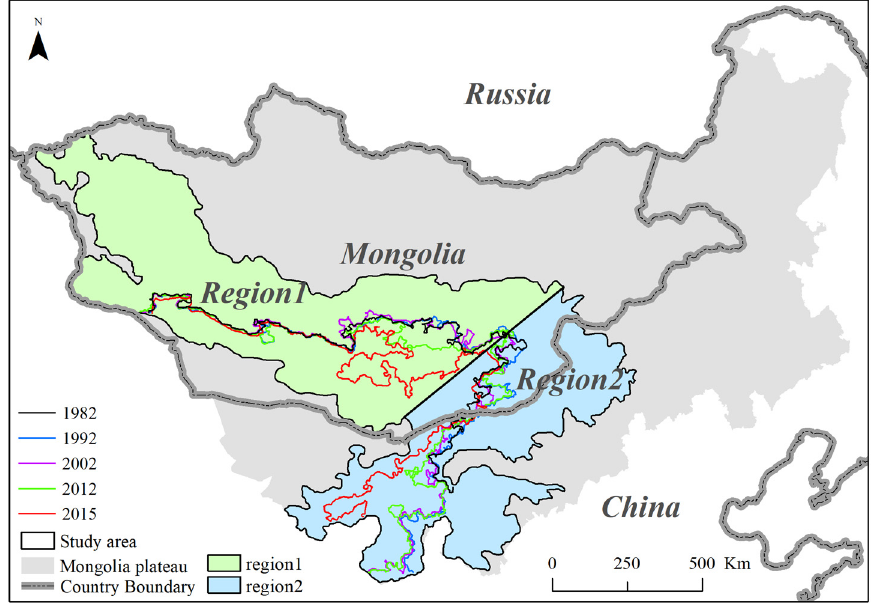
Figure 5. Spatial changes of vegetation greenness line during 1982–2015 in ASTZMP. To quantify the latitudinal and longitudinal changes in the vegetation greenness line, we analyzed changes in the latitude (Region1) and longitude (Region2) at the center point of the vegetation greenness line (Figure 6a,b). Significant interannual variations in latitude (Region1) and longitude (Region2) were observed in the study area. Although the latitudi- nal change in the vegetation greenness line was not significant ( p > 0.05) in Region1 during 1982–2015, we identified three stages showing distinct changes (Figure 6a). The vegetation greenness line migrated southward at a rate of 0.042 ◦ per year ( p = 0.09) in Region1